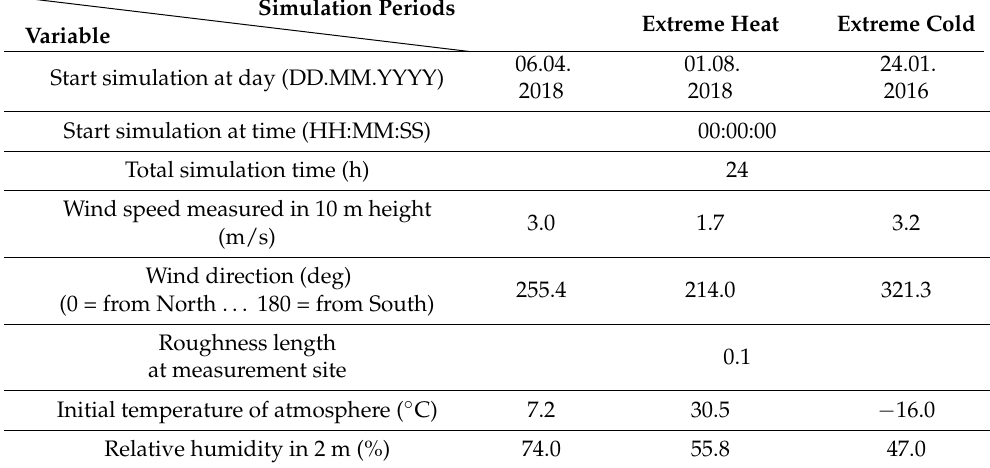
Table 1. Simulation execution